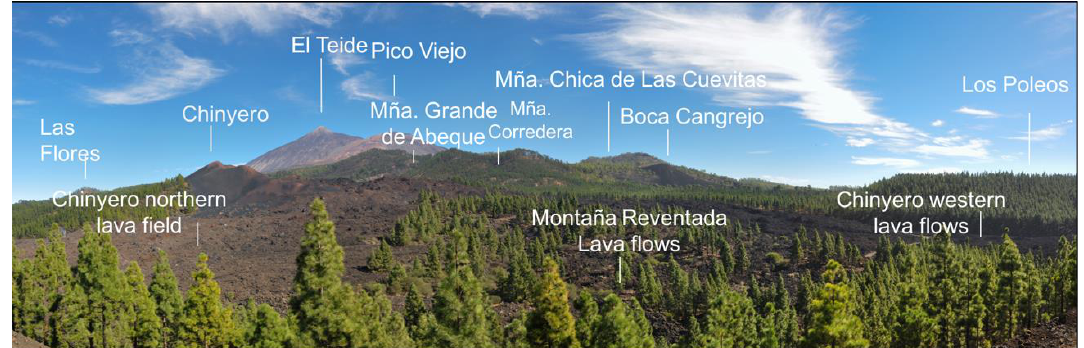
Figure 11. The landscape around the summits of Chinyero from Montaña de la Cruz. Source: authors, self-elaboration.